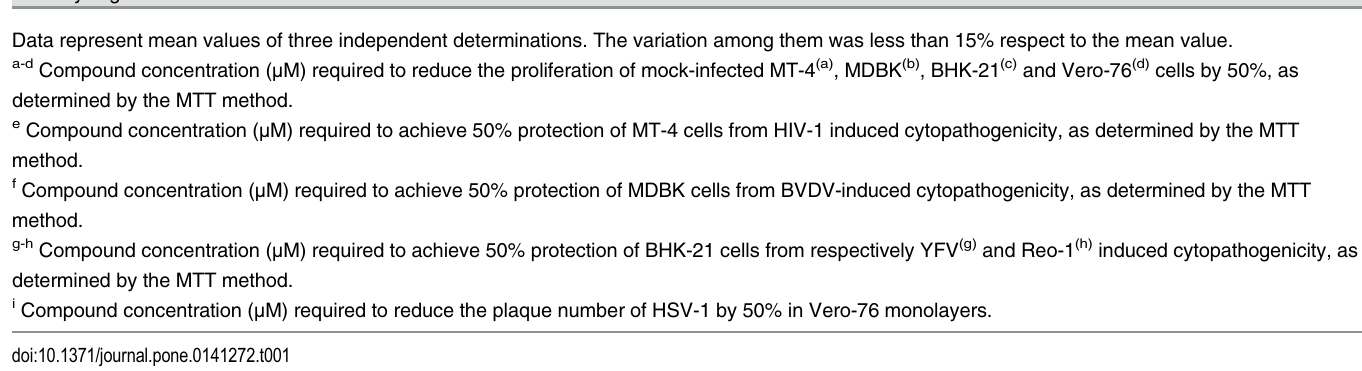
MTT assay Plaque assay